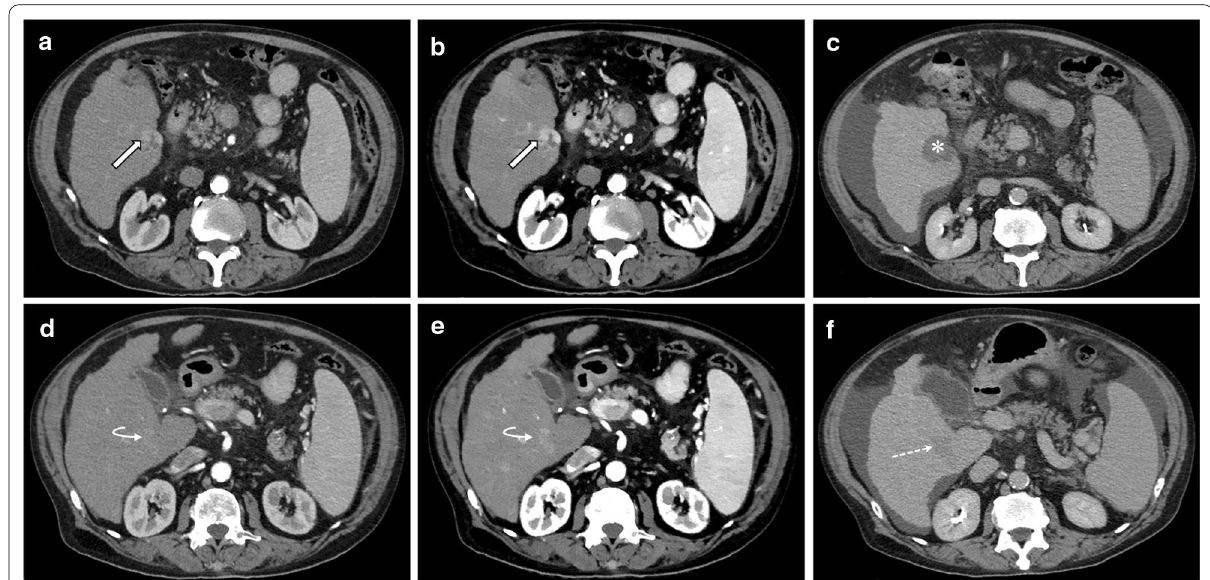
Fig. 5 Multiphasic spectral CT of a 73-year-old man with known HCC. The known tumor (arrows) shows typical hypervascularity on the conventional arterial phase ( a ) which is more prominent on 50 keV mono-energetic image ( b ), and was ablated with good treatment response (asterisk) on the 1-month follow-up ( c ). However, there was an additional lesion (curved arrow) which should have been suspected by the radiologist on baseline imaging but was missed owing to its minimal arterial enhancement ( d ). This lesion would not have been missed if 50 keV mono-energetic images had been reviewed prospectively ( e ), and on follow-up imaging showed definite washout and enlargement (dashed arrow), when the patient returned with advancing disease including tumor thrombus in the portal